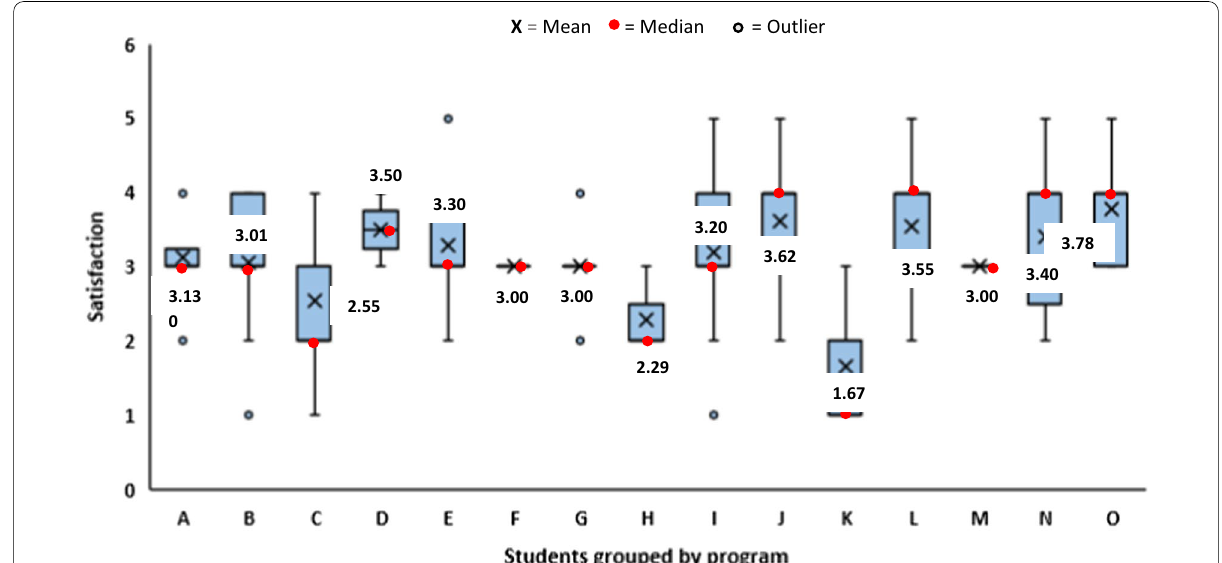
Fig. 5 Box plot to demonstrate and compare student’s satisfaction, on a five-point scoring system, with the performance of the institution in managing educational processes during the lockdown, grouped by program. The program names were replaced with alphabets to protect their privacy. In each box, the horizontal border represents the first and third quartiles of awarded marks, upper and lower whiskers represent the highest and lowest awarded marks for each cohorts, respectively, and interquartile range (IQR) rule was used to identify outliers. The box and whiskers of program F and M were reduced to a single line because student satisfaction values were densely populated on score 3 resulting in the highest and lowest scores as well as the first and third quartiles to be the same value, where 1